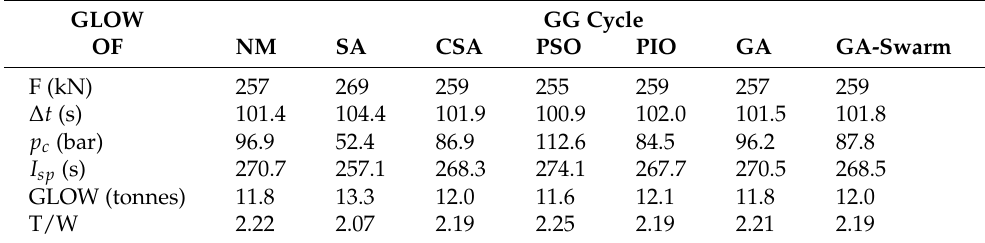
Table 9. GG Cycle: Values of Variables at max I sp for each technique. I sp OF